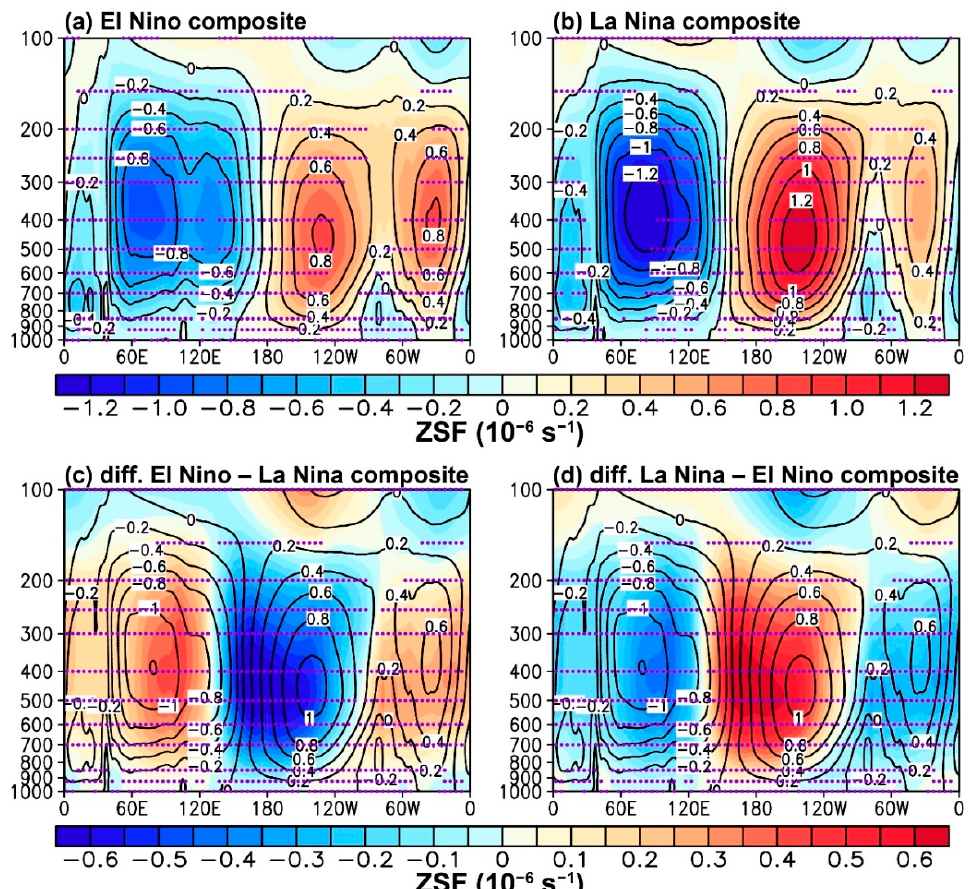
Figure 4. Composite of the zonal circulations along the equator (5° S–5° N) in JRA-55 reanalysis dataset [35] for ( a ) El Niño and ( b ) La Niña based on the ONI (5° S–5° N, 120° W–170° W). ( c ) Contours: mean state (1961–2012) of the zonal circulations; shading: difference between El Niño–La Niña; ( d ) same as ( c ) but for the mean state of the zonal circulations (contours) and difference between La Niña–El Niño (shading). The composites which are statistically significant at the 5% confidence level are dotted in purple. Diff.: means minus in math.